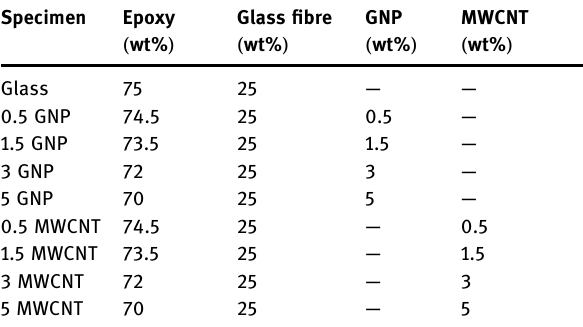
Table 2: Mixing portion of glass reinforced GNP and MWCNT composites Specimen